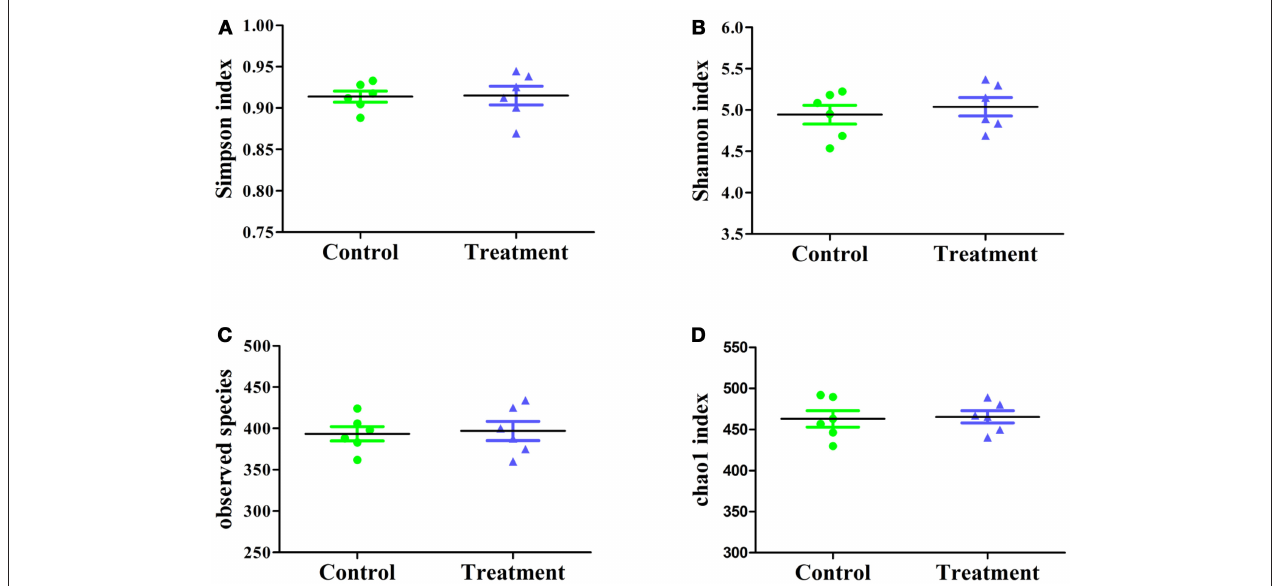
FIGURE 7 | Cecal microbiota α -diversity in male rats after oral administration of Enterococcus durans KLDS6.0930 for 28 days. Control, sterile normal saline; Treatment, 1 × 10 9 CFU of E. durans KLDS6.0930 /kg BW. (A) Simpson index, (B) Shannon index, (C) observed species, (D) Chao1 index.